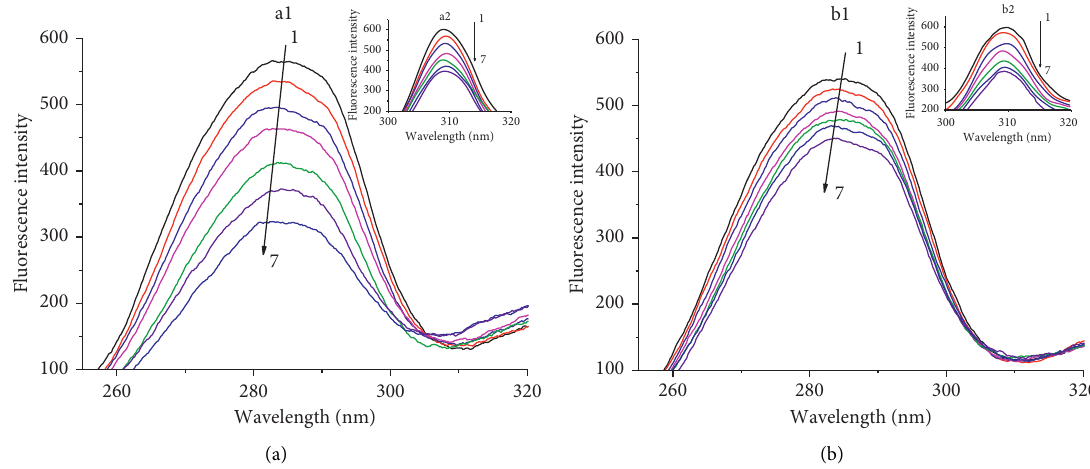
Figure 2: Synchronous fluorescence spectra of luteolin-LYSO (a1) and luteoloside-LYSO (b1) and fluorescence quenching spectra of luteolin-LYSO (a2) and luteoloside-LYSO(b2), when Δ λ � 60 nm, T � 298K. From curve 1 ⟶ 7, C (LYSO) � 1.0 μ mol/L, C (luteolin) � C (luteoloside) � 0, 1.0, 2.0, 3.0, 4.0, 5.0, and 6.0 μ mol/L, respectively.